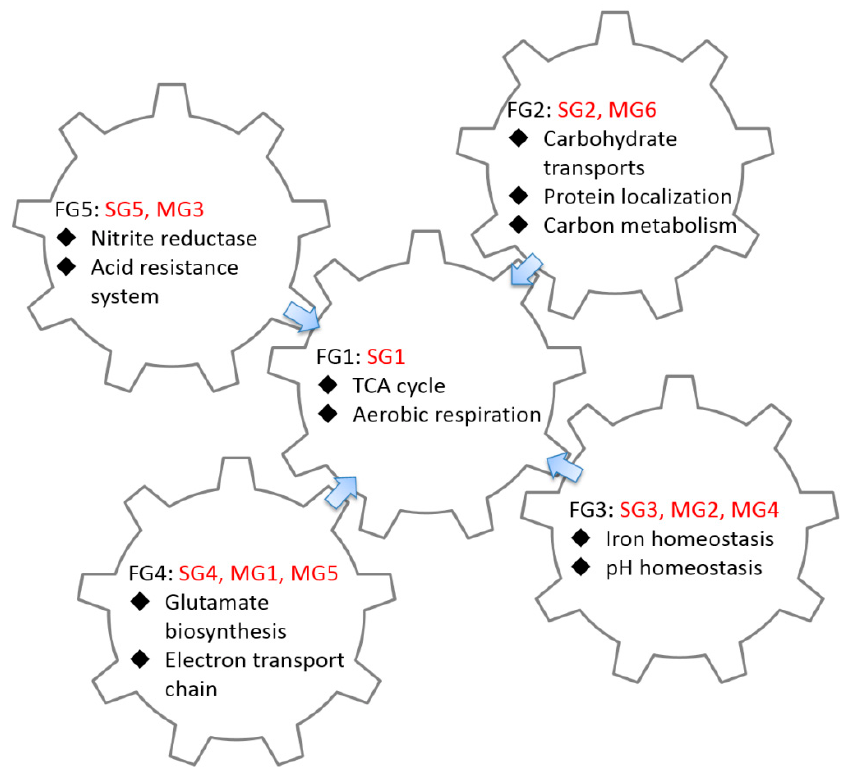
Figure 5. Biological interactions of CRP-FFLs. Expression patterns of target genes can be divided into five functional groups (FG1 to FG5). Each group combines single- or multi-TFs CRP-FFLs involved in different biological functions, such as carbon metabolism, transport and iron and pH homeostasis.